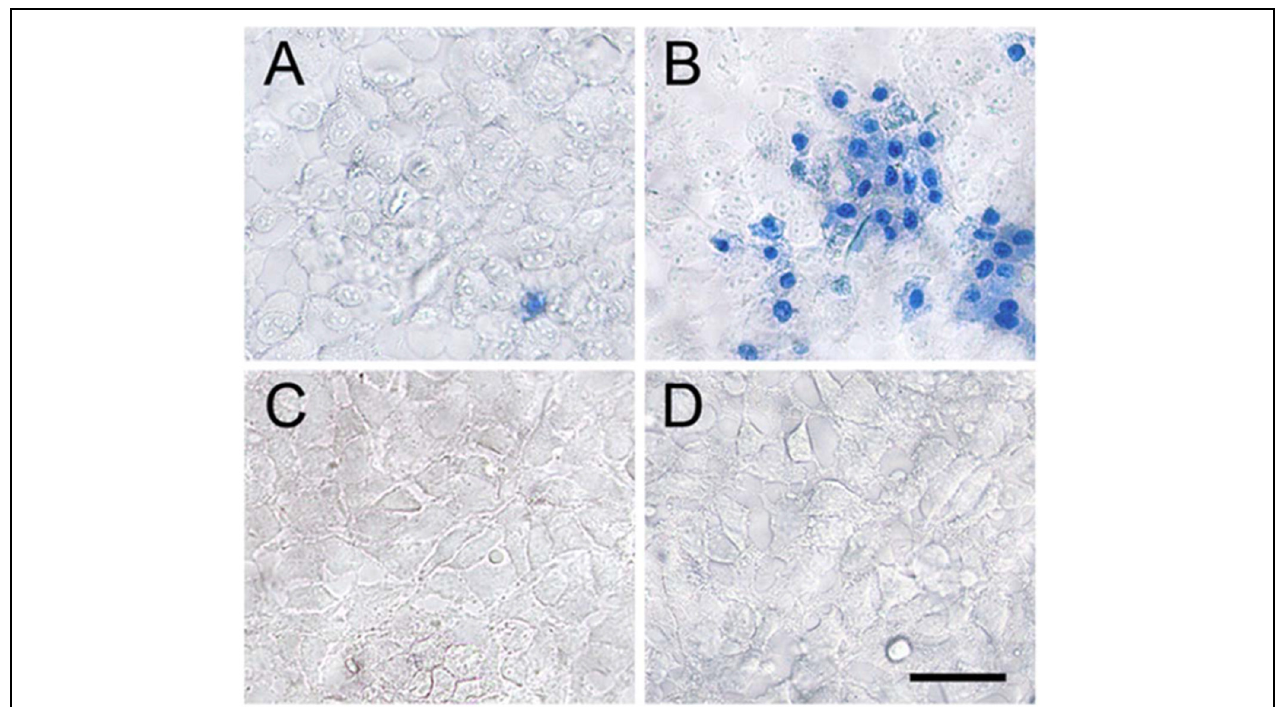
FIGURE 3 | Effect of ASH in reversal of β -Amyloid induced cell death. Treating the SK-N-MC cells with β -Amyloid (B) resulted in significant cell death when compared to the untreated control cells (A) . Treating the cells with ASH (C) and ASH plus β -Amyloid (D) exhibited good viability as evidenced by exclusion of trypan blue dye. [Reproduced with permission from (Kurapati et al.,